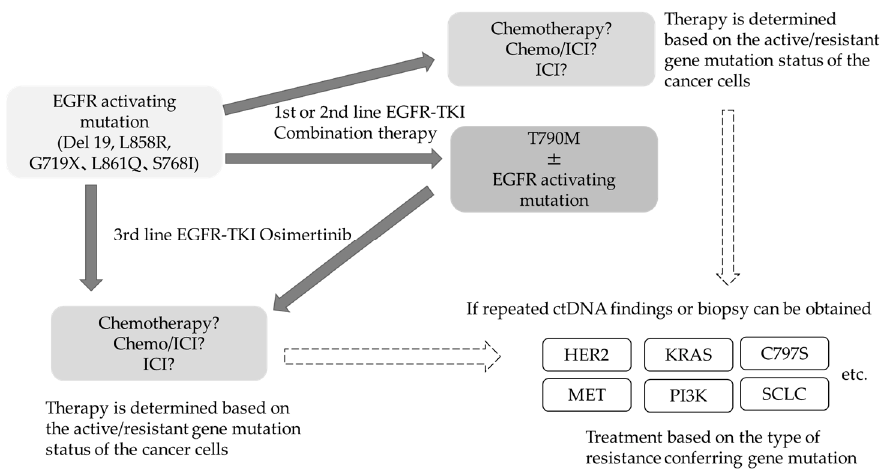
Figure 1. Future prospects of treatment algorithms for EGFR mutation-positive lung cancer.